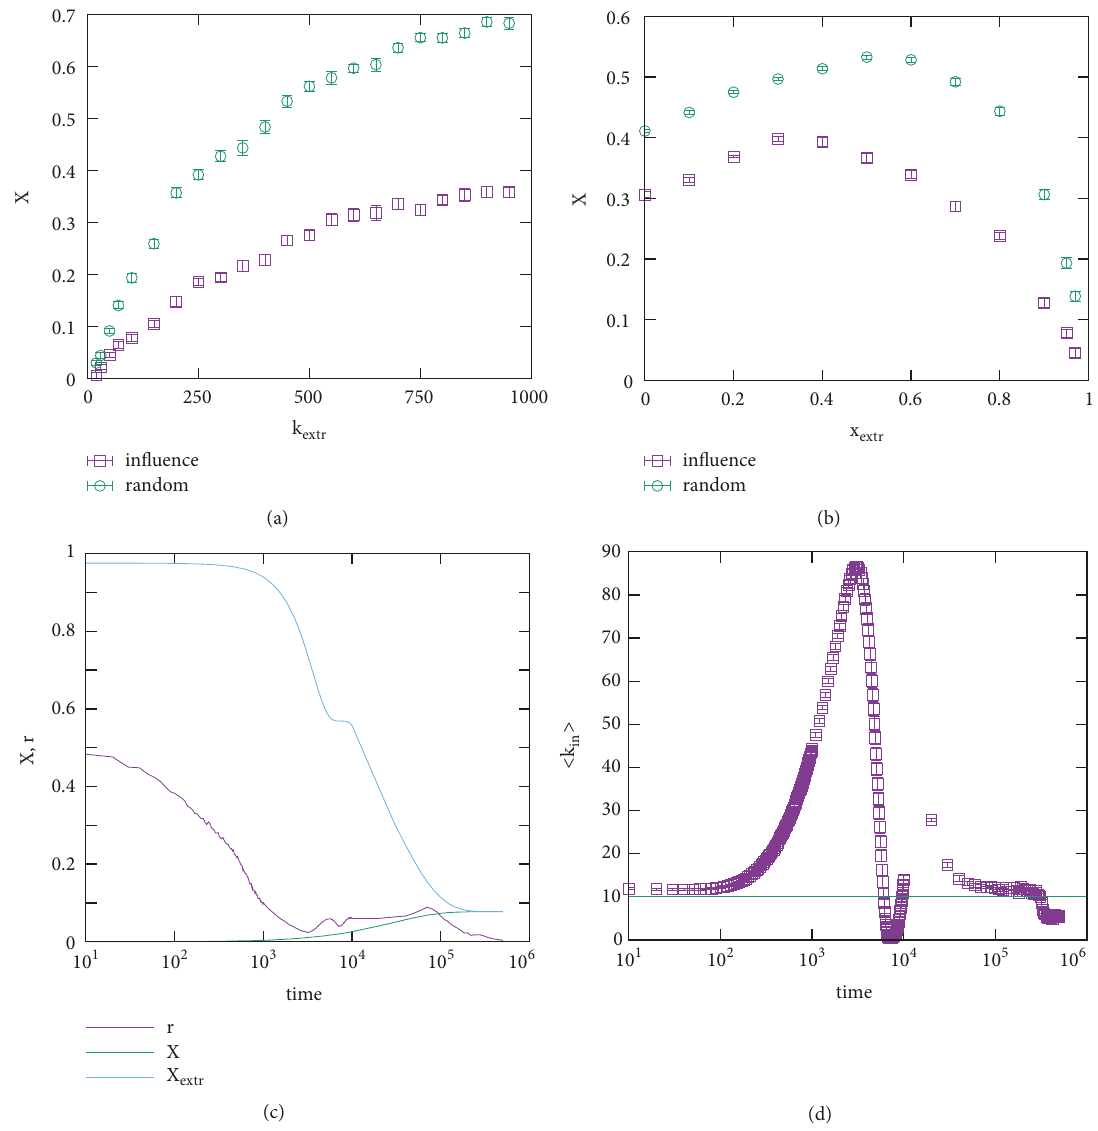
Figure 6: Dependence of mean consensus 푋 on the presence of influential minorities. (a) Dependence of 푋 on the out-degree of minority agents 푘 extr ina setting wherenormalagentshaveout-degree 푘 out = 10 .Minority agentsare defined asagentswith initial opinions 푥 𝑖 (0) > 0.95 . (b) Dependence of mean consensus 푋 on a threshold 푥 extr in a setting in which normal agents have 푘 out = 10 and agents with initial opinion 푥 (0) > 푥 푘 = 100 . (c) Evolution of the spread of the mean 푋 for all agents and mean 푋 𝑖 extr are assigned out-degree out group and spread of consensus state 푟 over time. (d) Evolution of the in-degree 푘 in of minority agents over time. Results are averaged over 20 independent runs for a system of 푁 = 1000 nodes, noise Δ = 0 , and ⟨푘⟩ = 10 . To emphasize the effects of influence maximizing rewiring, the time constant for opinion convergence is chosen one order of magnitude smaller than in the rest of the paper ( 훼 = 10 −5 ) and we use a large value of 푚 = 100 . Panels (c) and (d) are for 푥 extr = 0.95 and 푘 extr = 100